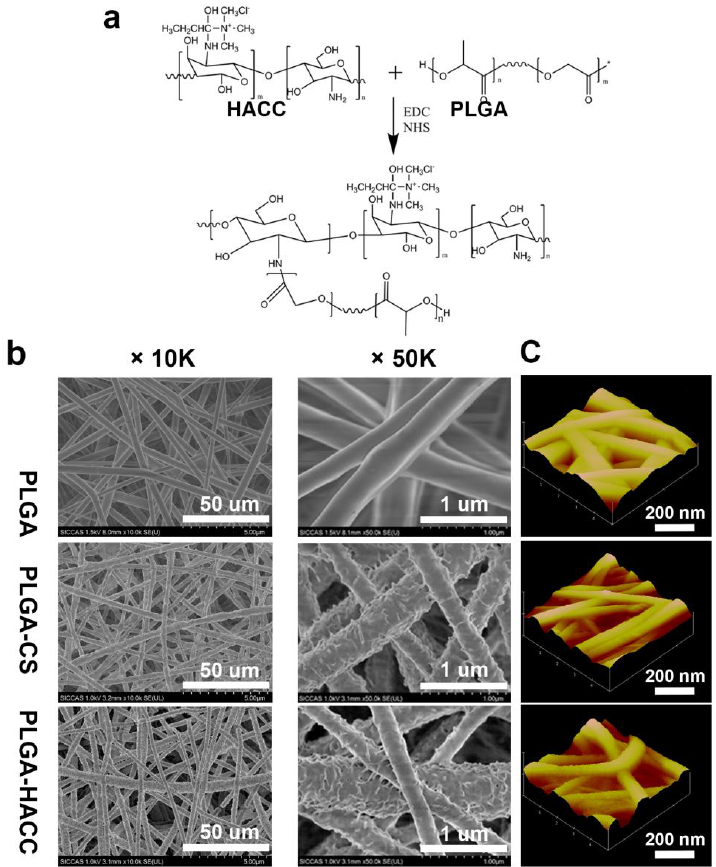
Figure 1. Schematic illustration of HACC-modified electrospun PLGA nanofibrous membrane ( a ) and SEM images ( b ) and AFM images ( c ) of the pure PLGA, the PLGA-chitosan (CS) and PLGA-HACC fibrous membranes.